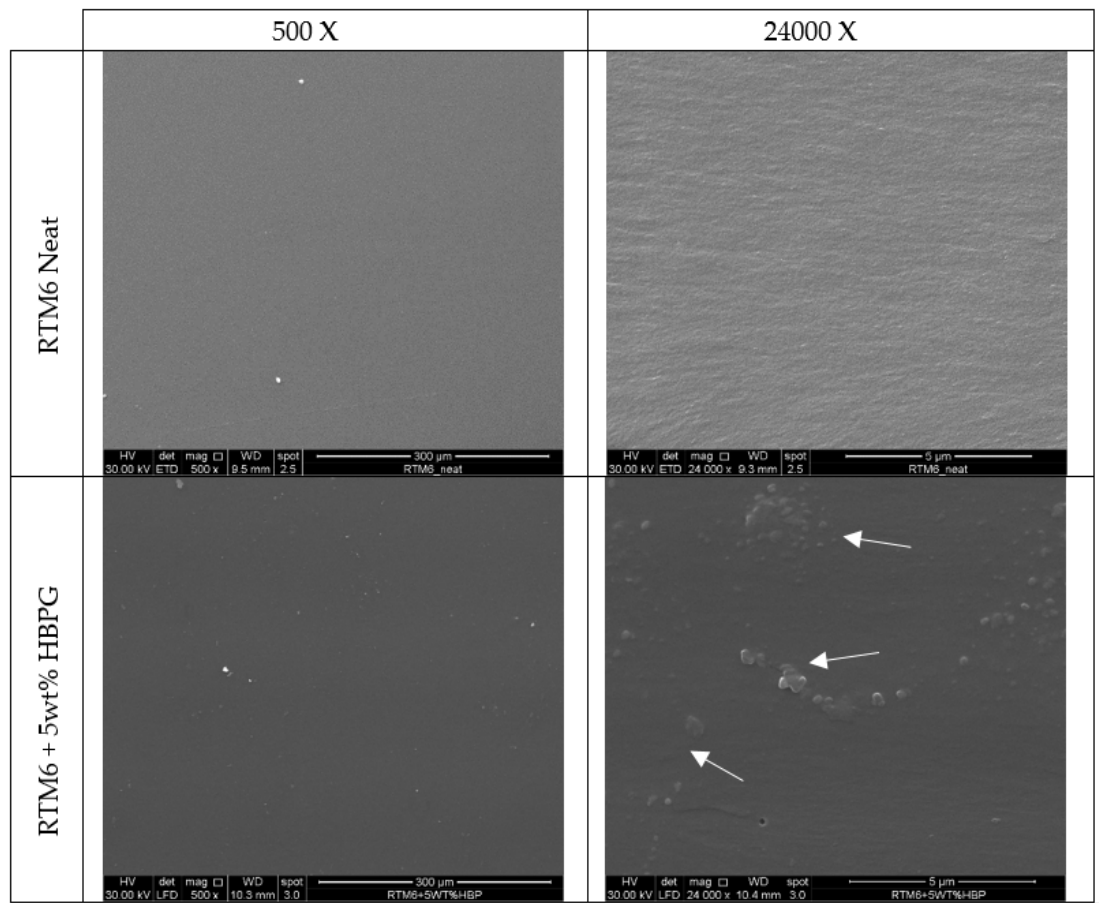
Figure 15. SEM images of fracture surfaces of neat RTM6 and 5 wt% AHBP loaded RTM6 samples.